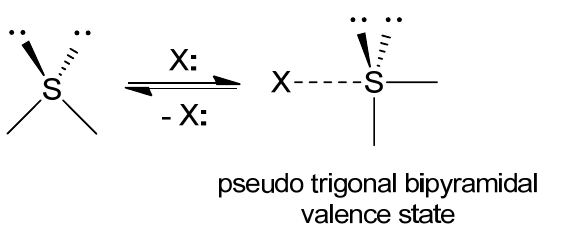
Figure 1. Hypervalent nonbonded S···X interactions of a divalent sulfur atom.